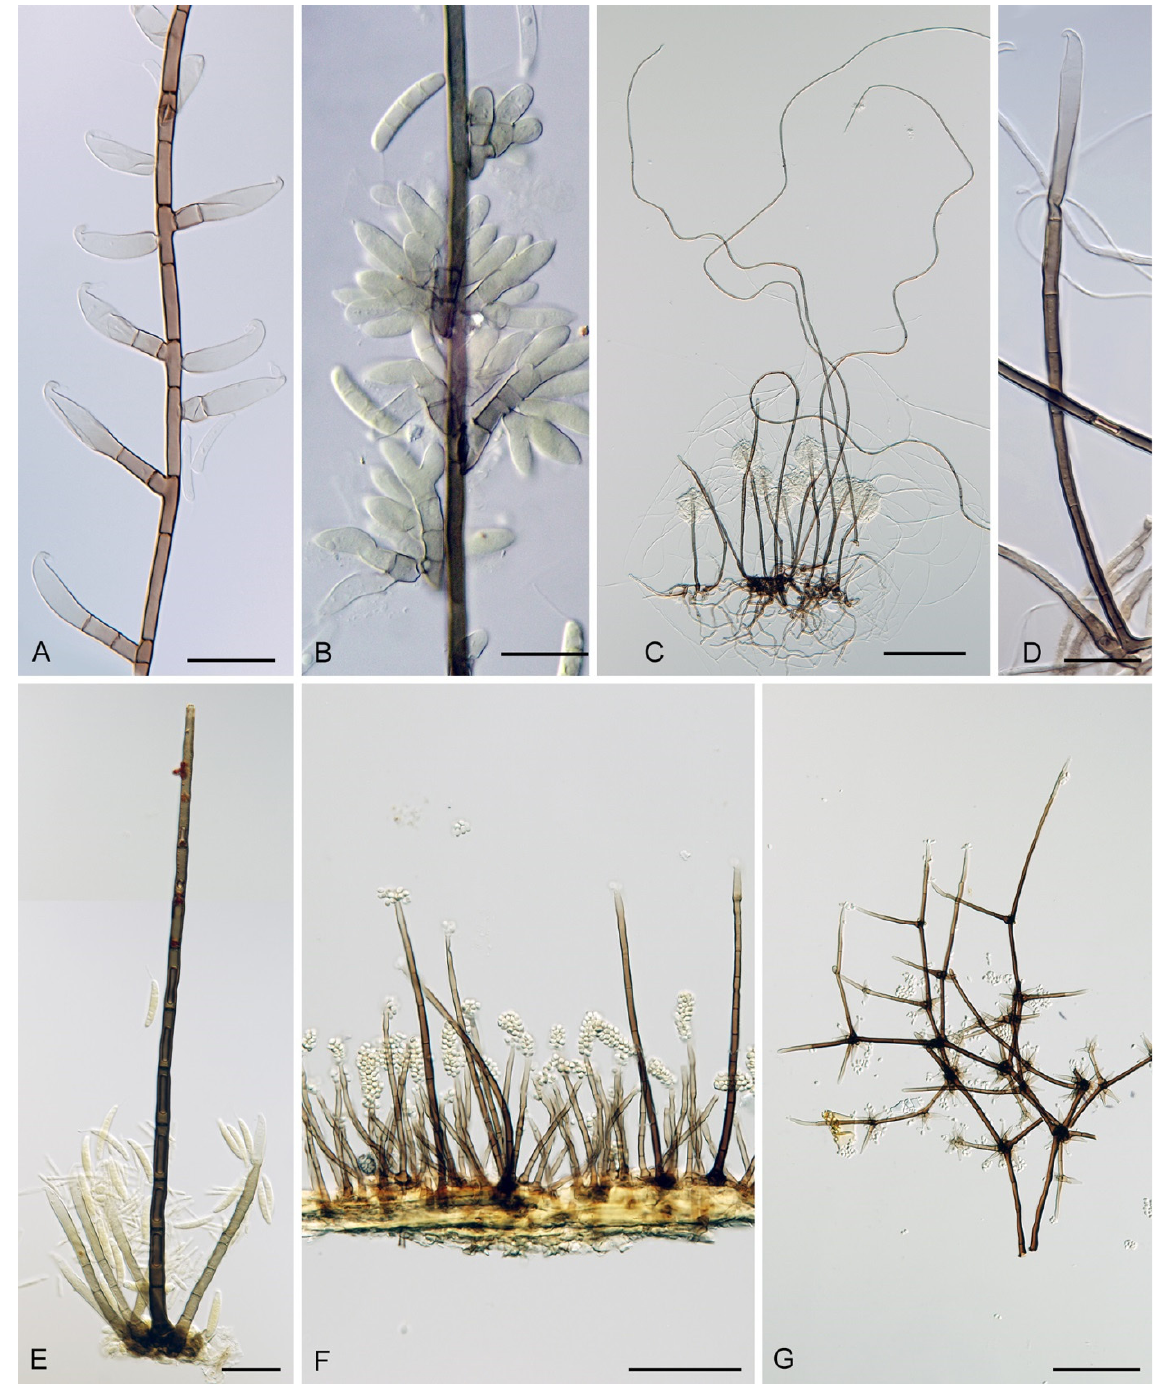
Figure 9. Selected morphotypes of Menispora and Chloridium . ( A ) M. ciliata morphotype M2 (CBS 122131); ( B ) M. tortuosa morphotype M3 (CBS 117552) ( C , D ) M. uncinata morphotype M4 (ICMP 18253) ( E ) M. britannica morphotype M1 (PRA-20985) ( F ) Chl. virescens morphotype CH1 (M.R. 3886) ( G ) Chl. caesium morphotype CH3 (M.R. 1883). Scale bars: ( A , B , D , E ) 20 μ m; ( C ) = 100 μ m; ( F , G ) 50 μ m.